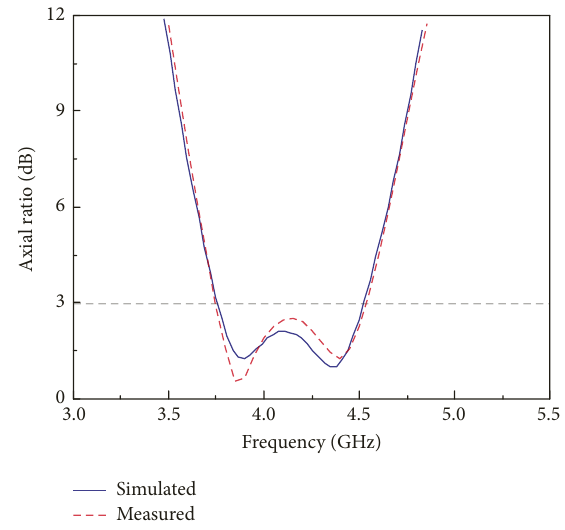
Figure 12: Simulated and measured axial ratio of the antenna.